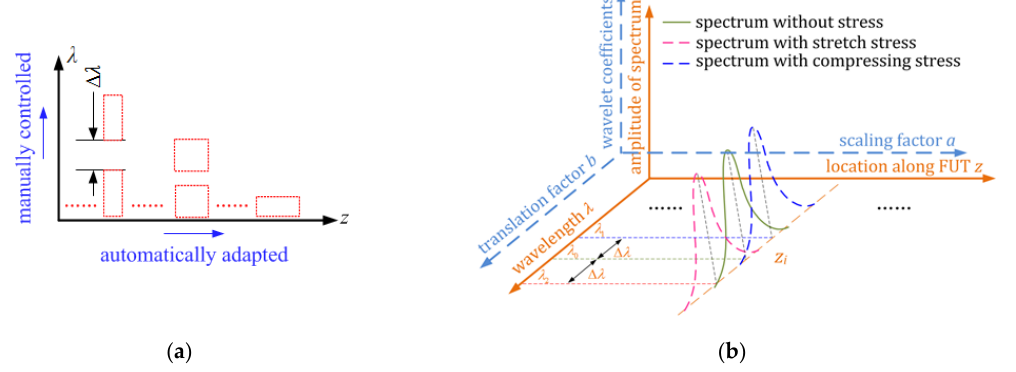
Figure 3. Diagram of demodulating OFDR signals by wavelet transformation (WT) method. ( a ) the spectrum-position characteristics of WT; ( b ) the relationship between the distributed sensing and WT parameters.